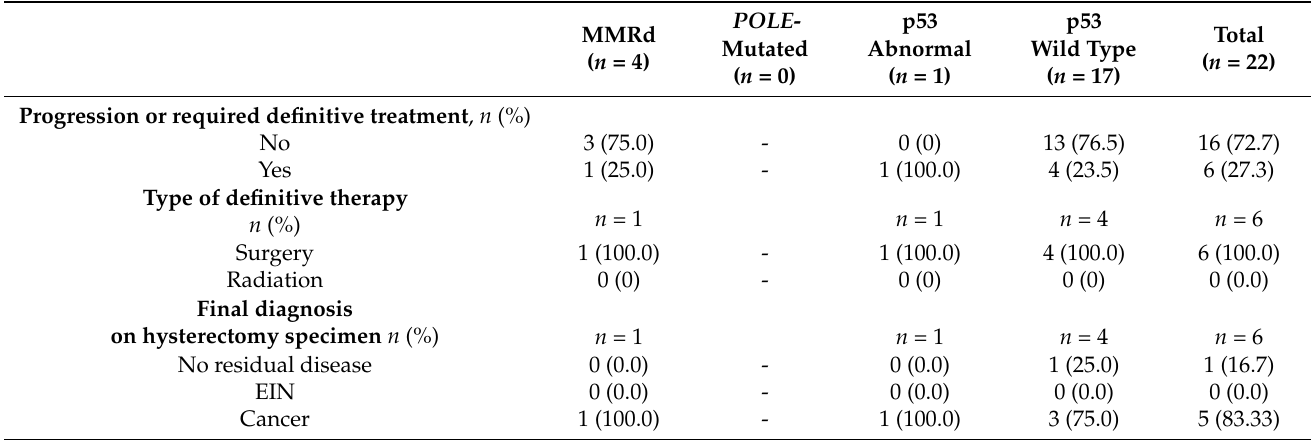
Table 4. Molecular characterization of patients with endometrial adenocarcinoma ( n = 22) and